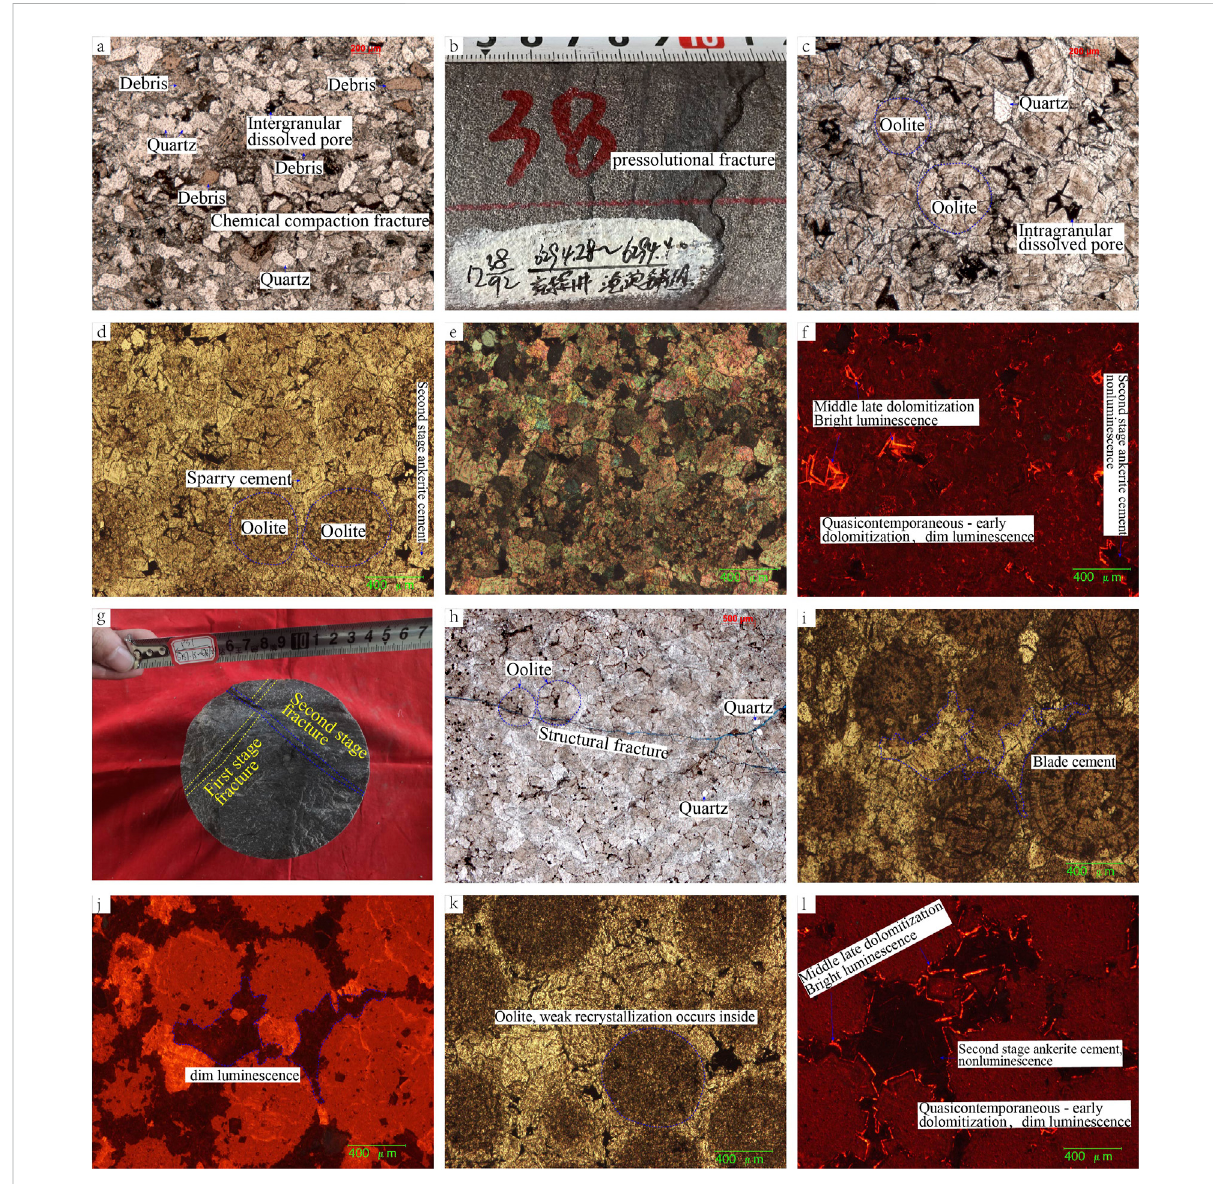
FIGURE 4 Macro and micro features of typical diagenesis observed in the target layer. (A) Chemical compaction fracture fully fi lled with asphalt, fi ne- grained detrital sandstone, Well PS1, 6783.72 m, single polarized light, dyed cast thin section; (B) Chemical compaction fracture fully fi lled with asphalt,graysparryooliticdolomite,6294.28 – 6294.40 m,corephoto; (C) Polycrystallineoolitesformedbydolomitization,residualooliticdolomite, Well CT1, 6273.74 m, single polarized light, dyed cast thin section; (D) Sparry oolitic dolomite, Well DB1, 5945.5 m, single polarized light, dyed cast thin section; (E) Orthogonal polarized light image of sample d; (F) Cathodoluminescence image of sample e; (G) The structural dissolution fractures of the fi rst phase are cut by the structural dissolution fractures of the second phase. Gray sand-bearing oolitic dolomite, Well PS1, 6787.15 – 6787.24 m, core photo; (H) Un fi lled structural dissolution fractures. Sparry residual oolitic dolomite, Well DB1, 5947.5 m, single polarized light, dyed cast thin section; (I) Horses tooth-like cement in seawater diagenetic environment, and its cathodoluminescence characteristic is